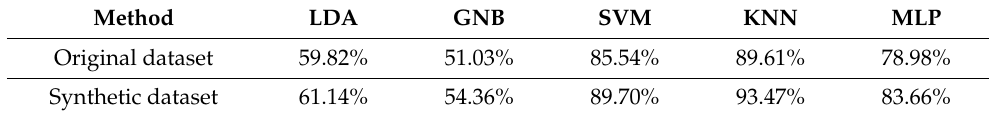
Table 4. Classification accuracy of each classification model on the test